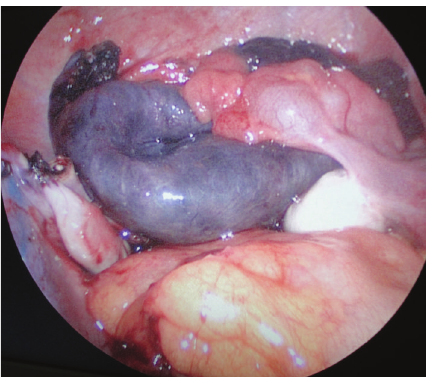
Figure 1: Normal ovaries with gangrene of the distal third of the left fallopian tube and paratubal cyst (postdetorsion and excision view). The right fallopian tube is seen with a few small paratubal cysts.